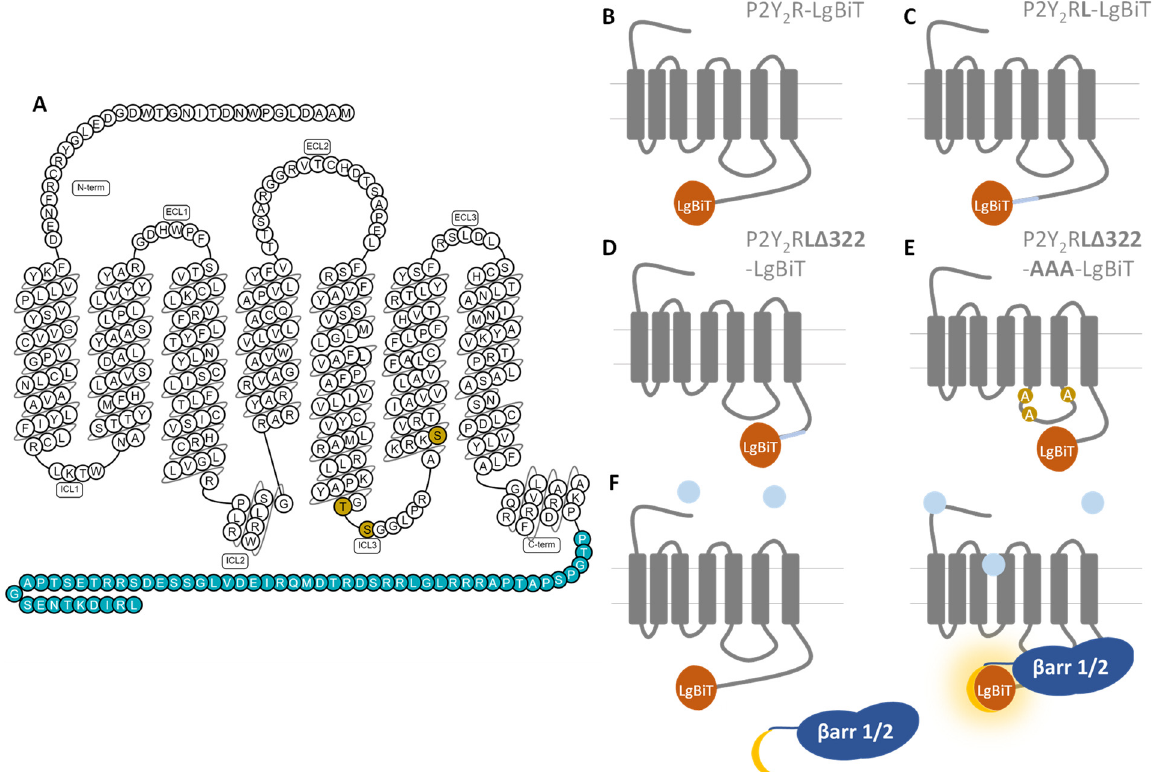
Figure 1. Schematic depiction of the experimental details of this manuscript. ( A ) P2Y 2 R snake plot (constructed on gpcrdb.org, last accessed 02/03/2022), with the residues removed in the truncated receptor constructs ( Δ 322 ) depicted in blue, and the mutated residues in IL3 ( AAA ) is shown in gold. Interaction with UTP supposedly occurs in the binding pocket generated by the upper parts of TM III, VI, and VII [22]. ( B – E ) Schematic overview of the generated receptor (mutant) constructs, with the exception of P2Y 2 R Δ 322 -LgBiT, which is C-terminally truncated but contains the original linker. ( F ) Schematic representation of the luminescence-based NanoBiT ® functional complementation assay, where agonist interaction with the receptor leads to recruitment of β arr1/2, functional complementation of the LgBiT and SmBiT enzyme fragments, and a luminescent signal.